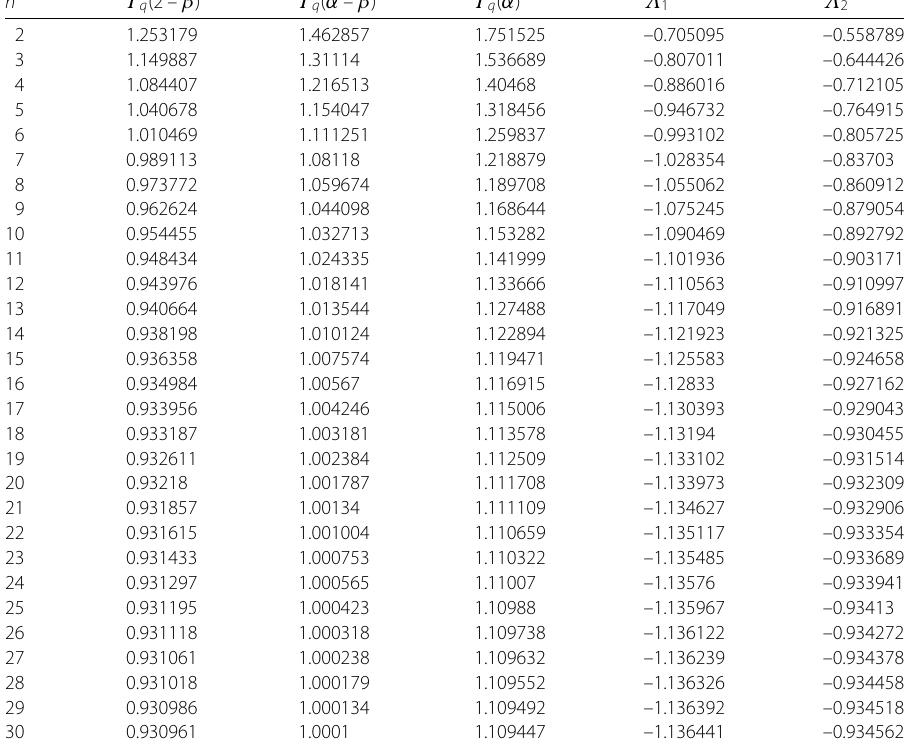
Table 6 Some numerical results for calculation of Λ 1 and Λ 2 with q = 3 Example